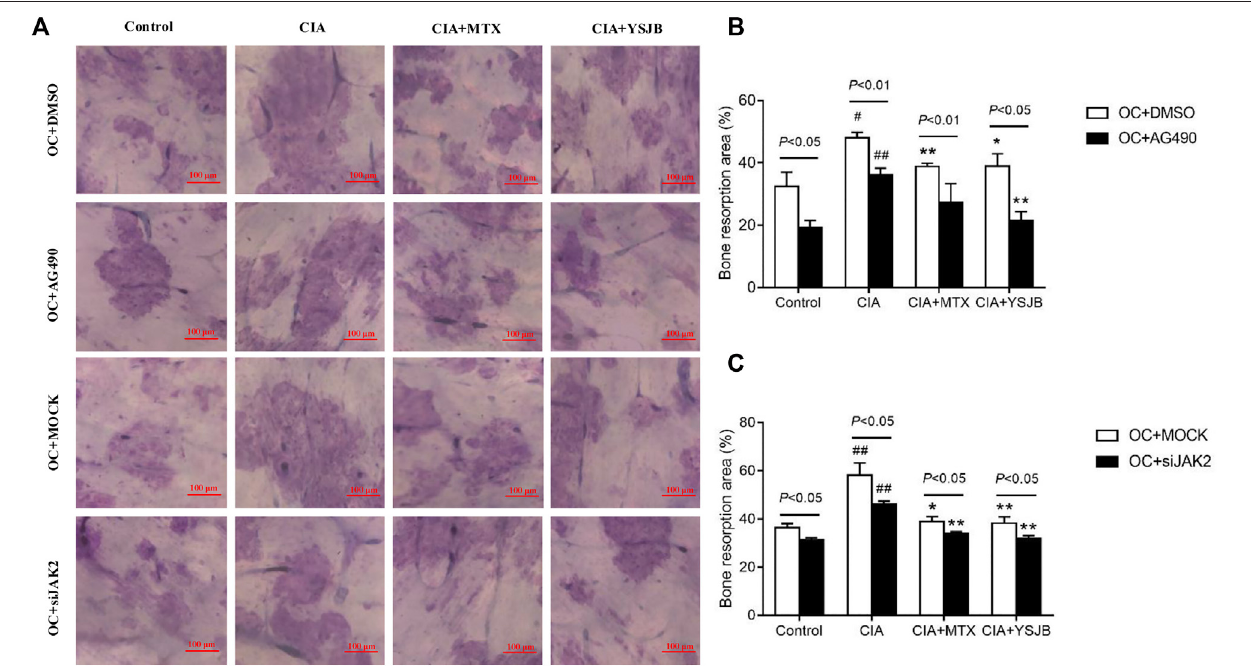
FIGURE 5 | Effect of YSJB, AG490 and JAK2 siRNA on bone resorption in the OC single culture system. (A) Images of bone resorption pits. Scale bar (cid:2) 100 μ m. (B,C) The areas of the bone resorption pits were measured by the image analysis program. The data are shown as the mean ± SEM (n ≥ 2). # p < 0.05, ## p < 0.01 compared with the control group; * p < 0.05, ** p < 0.01 compared with the CIA